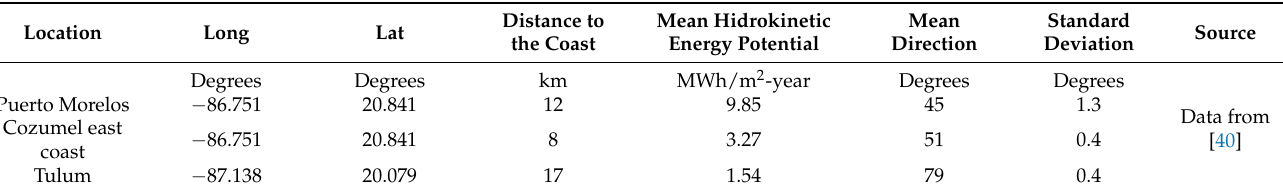
Table 2. The hydrokinetic potential in the study area.